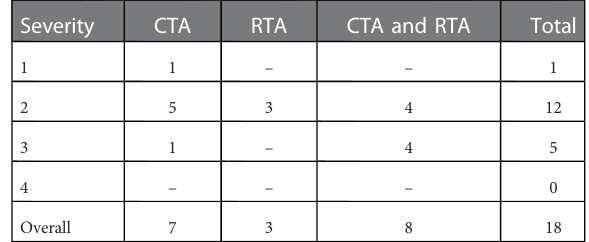
TABLE 2 Overview of distinct usability problems detected per method and rating of